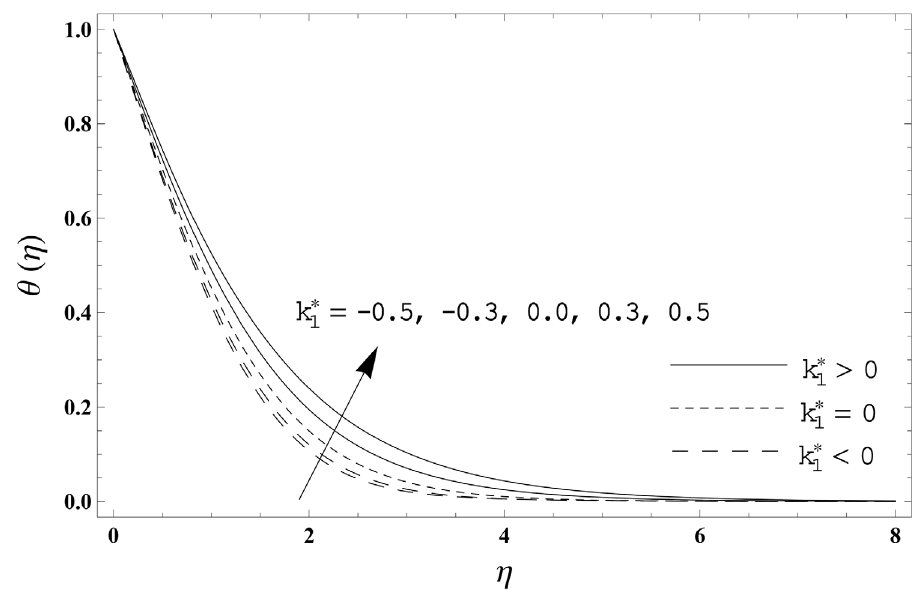
Fig 4. Effect of k (cid:3) 1 on θ ( η ) when γ = 0.3 and Pr = 1.0. doi:10.1371/journal.pone.0155185.g004 creates a reduction in the temperature distribution and thermal boundary layer thickness for both fl uids. Table 3 is computed to investigate the behavior of skin friction coef fi cient (cid:2) Re 1 = 2 : Tabulated values depict that the skin friction coef fi cient is higher for different values of k (cid:3) 1 < 0 Þ while opposite behavior is noticed for elastico-viscous fl uid for second grade fl uid ð k (cid:3) 1 > 0 Þ : Tables 4 and 5 include the values of heat transfer rate at the surface − θ 0 (0) for various ð k (cid:3) 1 values of thermal relaxation parameter γ for elastico-viscous ð k (cid:3)